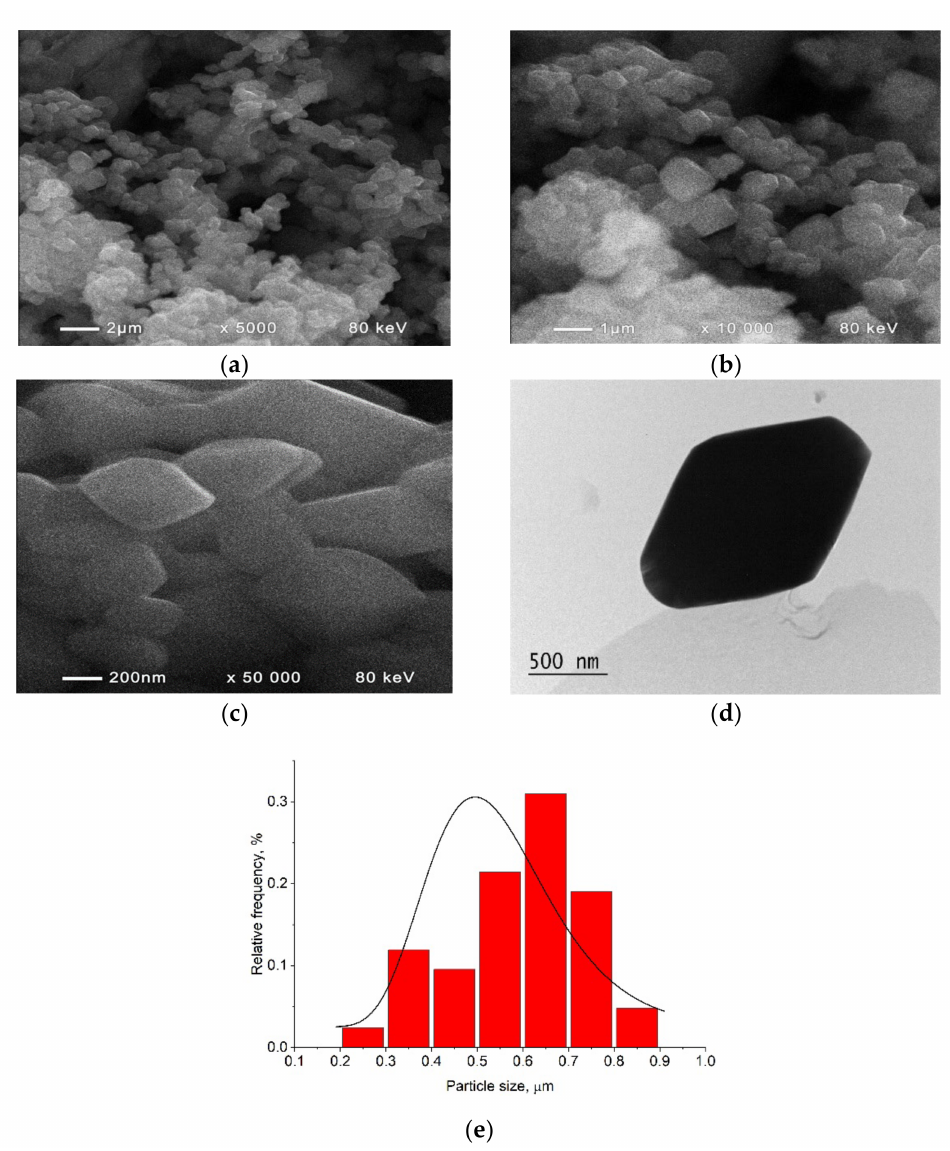
Figure 2. SEM images ( a – c ) and TEM image ( d ) of the sample Gd 1.92 Sm 0.05 Tb 0.03 (MoO 4 ) 3 . ( e ) Particle size distribution as obtained from the SEM